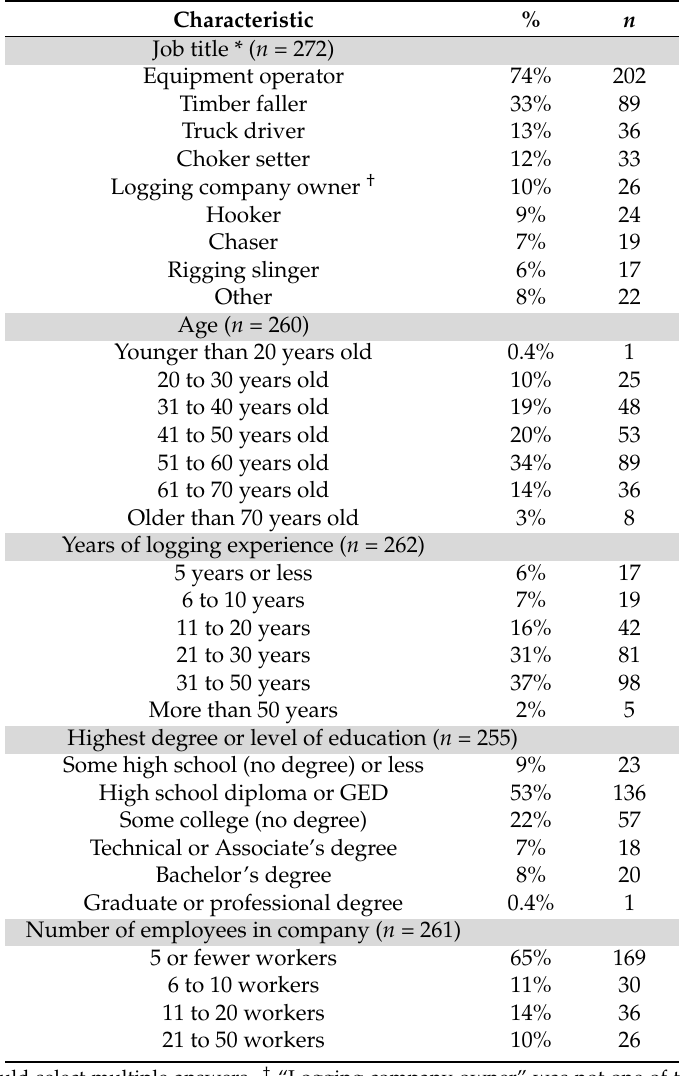
Table 3. Survey respondent